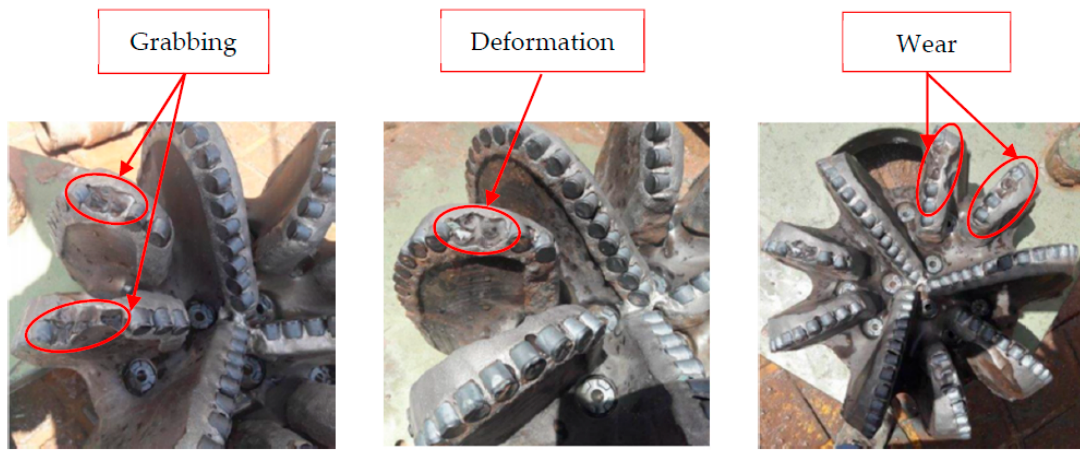
Figure 13. Drill bit damage due to stick-slip vibrations in Algerian hydrocarbons.